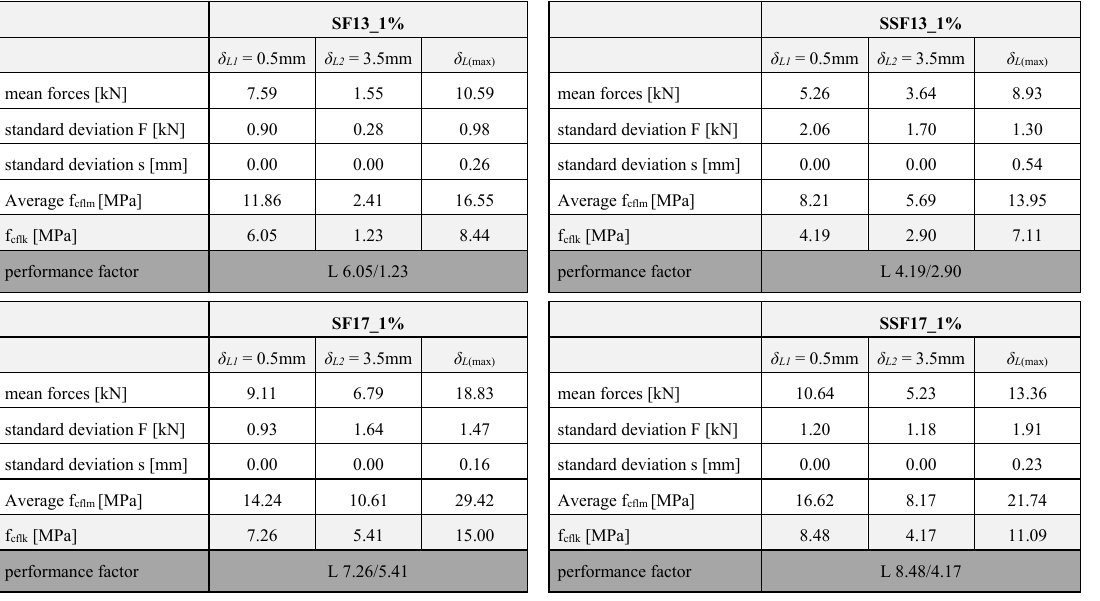
Table 4. Results of the flexural strength of the fibre material and length (constant fibre volumes of 1.0 vol%) and classification into performance classes.